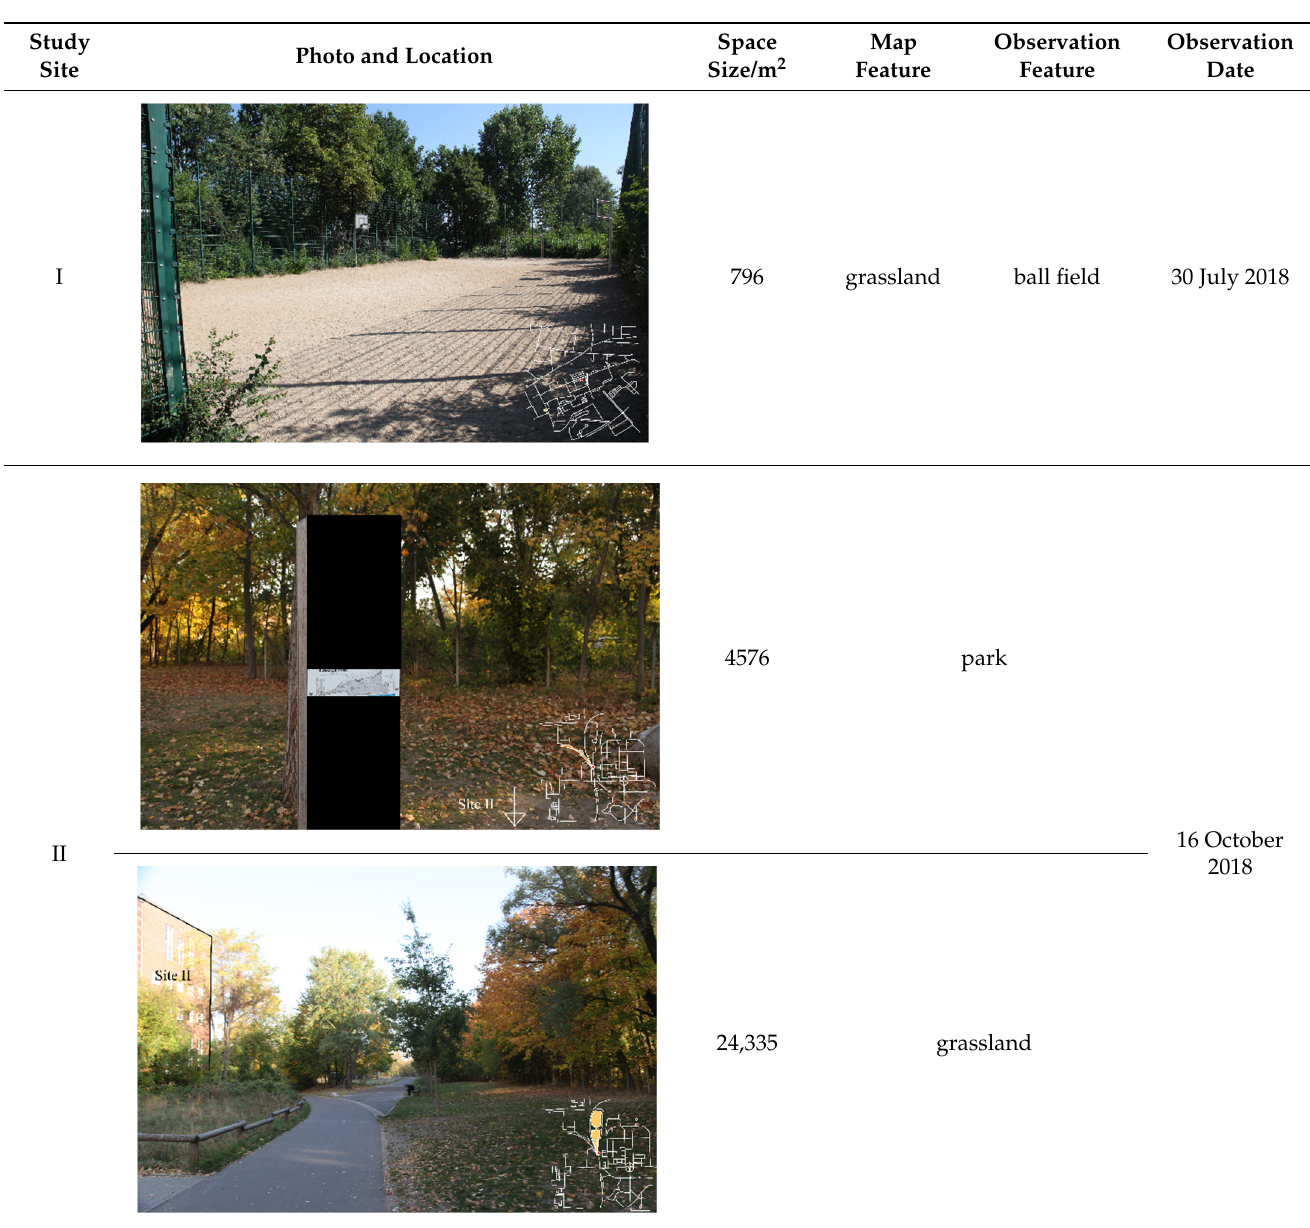
Table 3. Staff-identified neighbourhood playspace investigation.